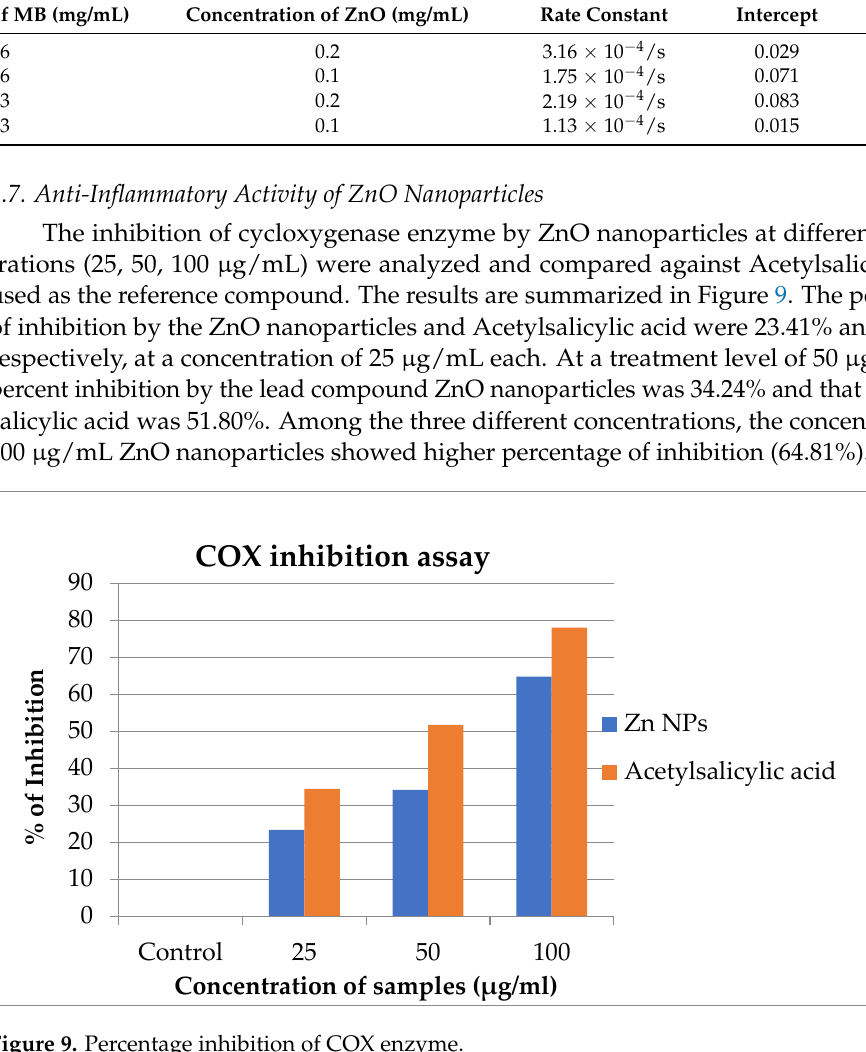
Figure 9. Percentage inhibition of COX enzyme.